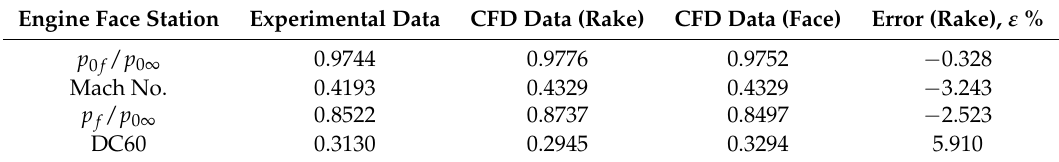
Figure 7. Illustration of the DC60 calculation approach. In the left, a 60-degree segment is shown which is at zero circumferential angle. The sector rotates clockwise one degree at a time. In the right, DC60 values for the 60-degree segment at each angle are shown. These plots correspond to simulation times of 2 and 2.25 s. Table 3. Validation data of the RAE-M2129 baseline intake. NASA grid was used with SARC–DDES turbulence model. CFD data are time-averaged from 2 to 2.5 s of simulation